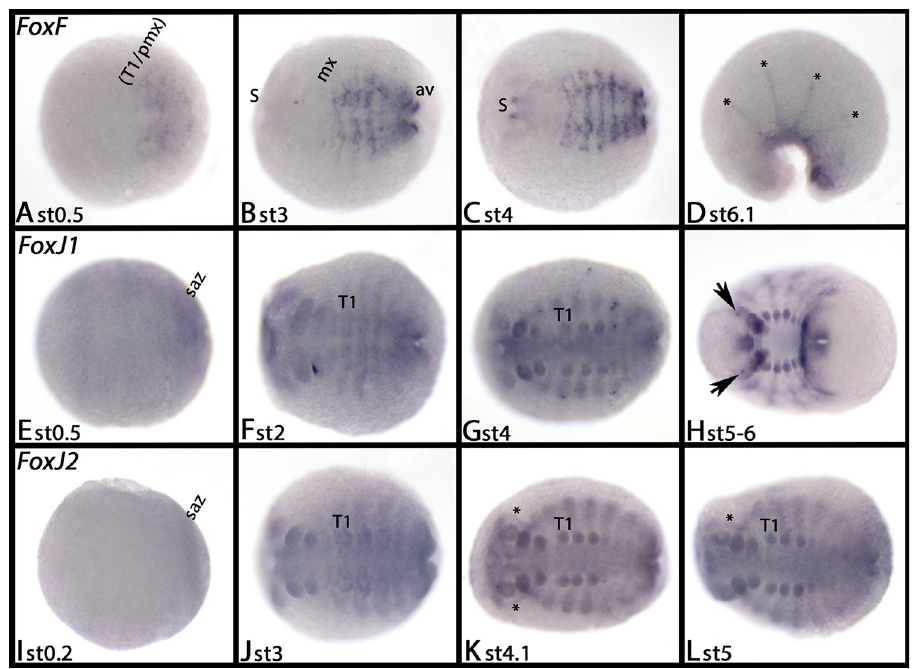
Fig 8. Expression of Glomeris FoxF (A-D), FoxJ1 (E-H) and FoxJ2 (I-L). In all panels, anterior is to the left, ventral views except panel D (lateral view, dorsal up). Asterisks in panel D mark expression in the tergite borders. Arrows in panel H mark dot-like expression in the head. Asterisks in panels K and L mark an area that is free of expression lateral in the head. Abbreviations in Table